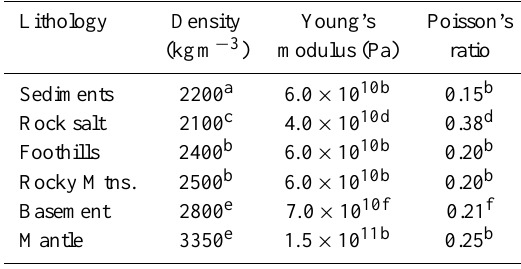
Table 1. Material properties of the Alberta model.